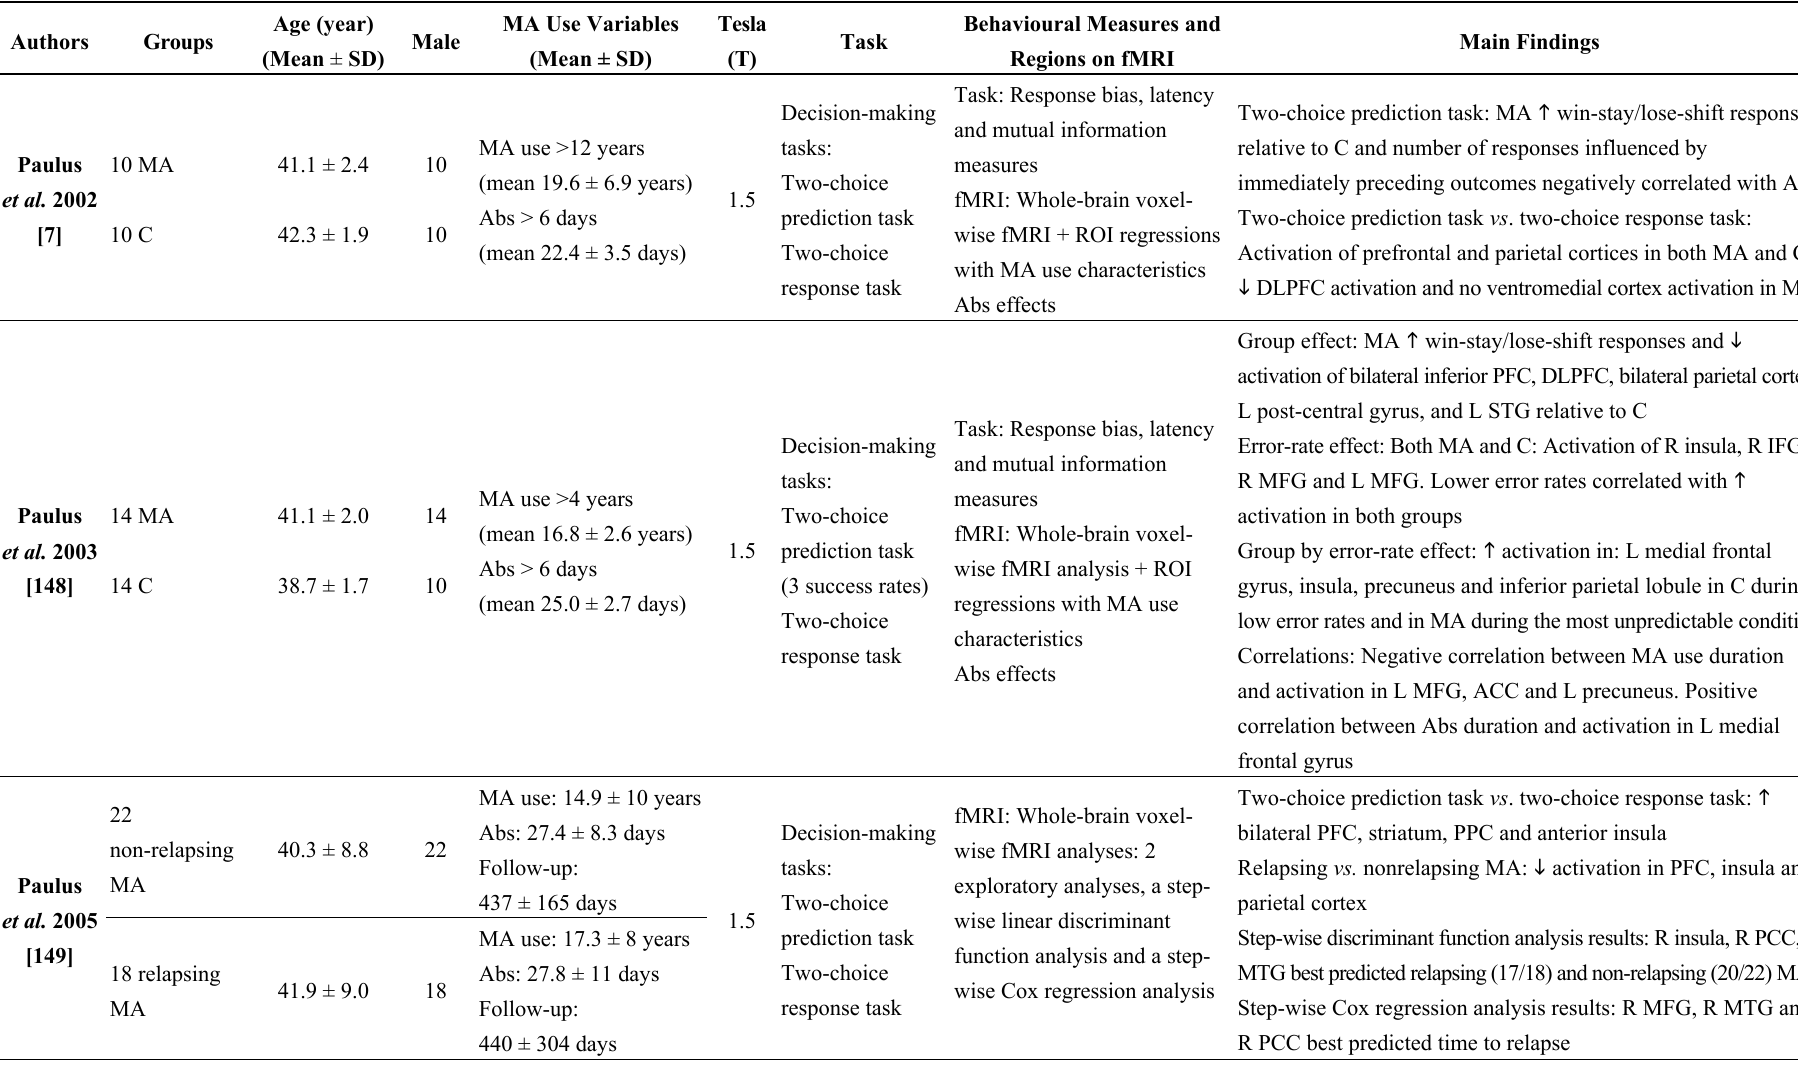
Table 2. Summary of study specifications and findings from fMRI studies of MA